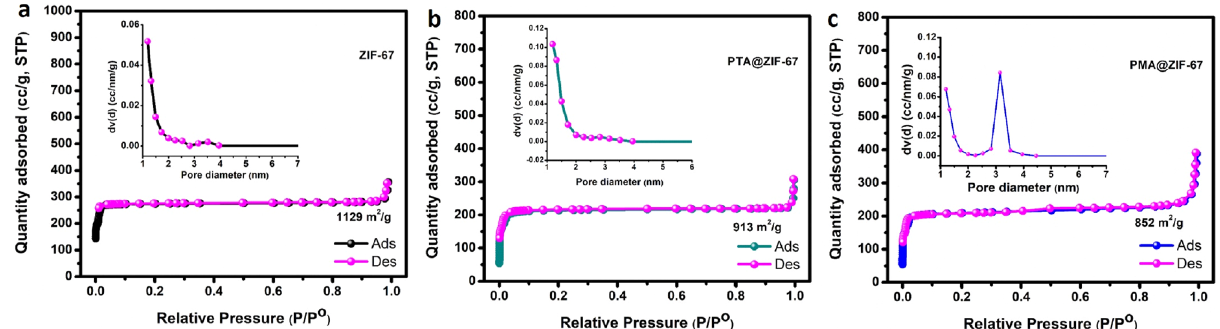
Figure 5. N 2 adsorption–desorption isotherms of the fabricated ( a ) bare ZIF-67, ( b ) PTA@ZIF-67 and ( c ) PMA@ZIF-67 samples with the insets showing the corresponding pore size